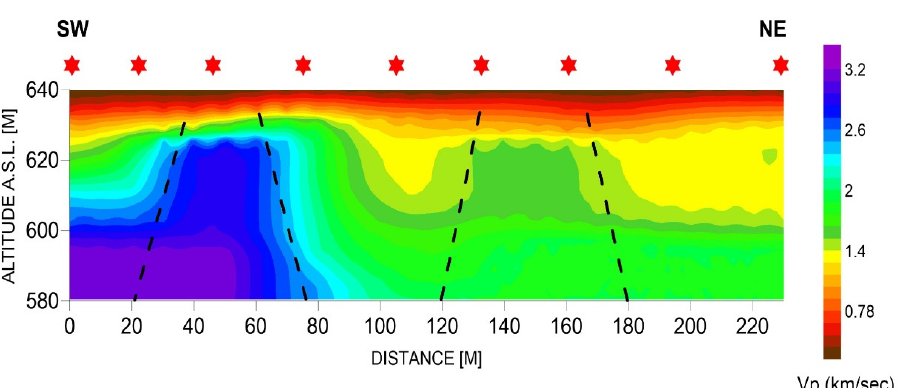
Figure 11. Results of profile Seis_1 (see Figure 3) with the detection of inferred position of faults (black dashed lines).